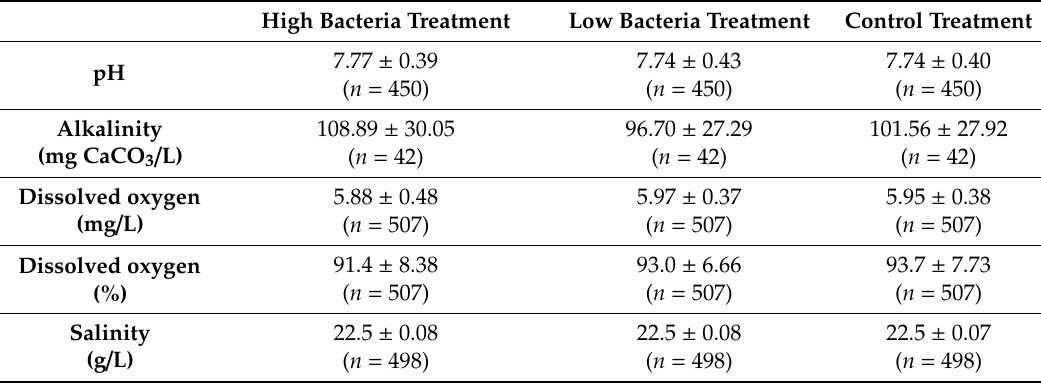
Table 1. Average and standard deviation of pH, alkalinity, salinity, dissolved oxygen concentration